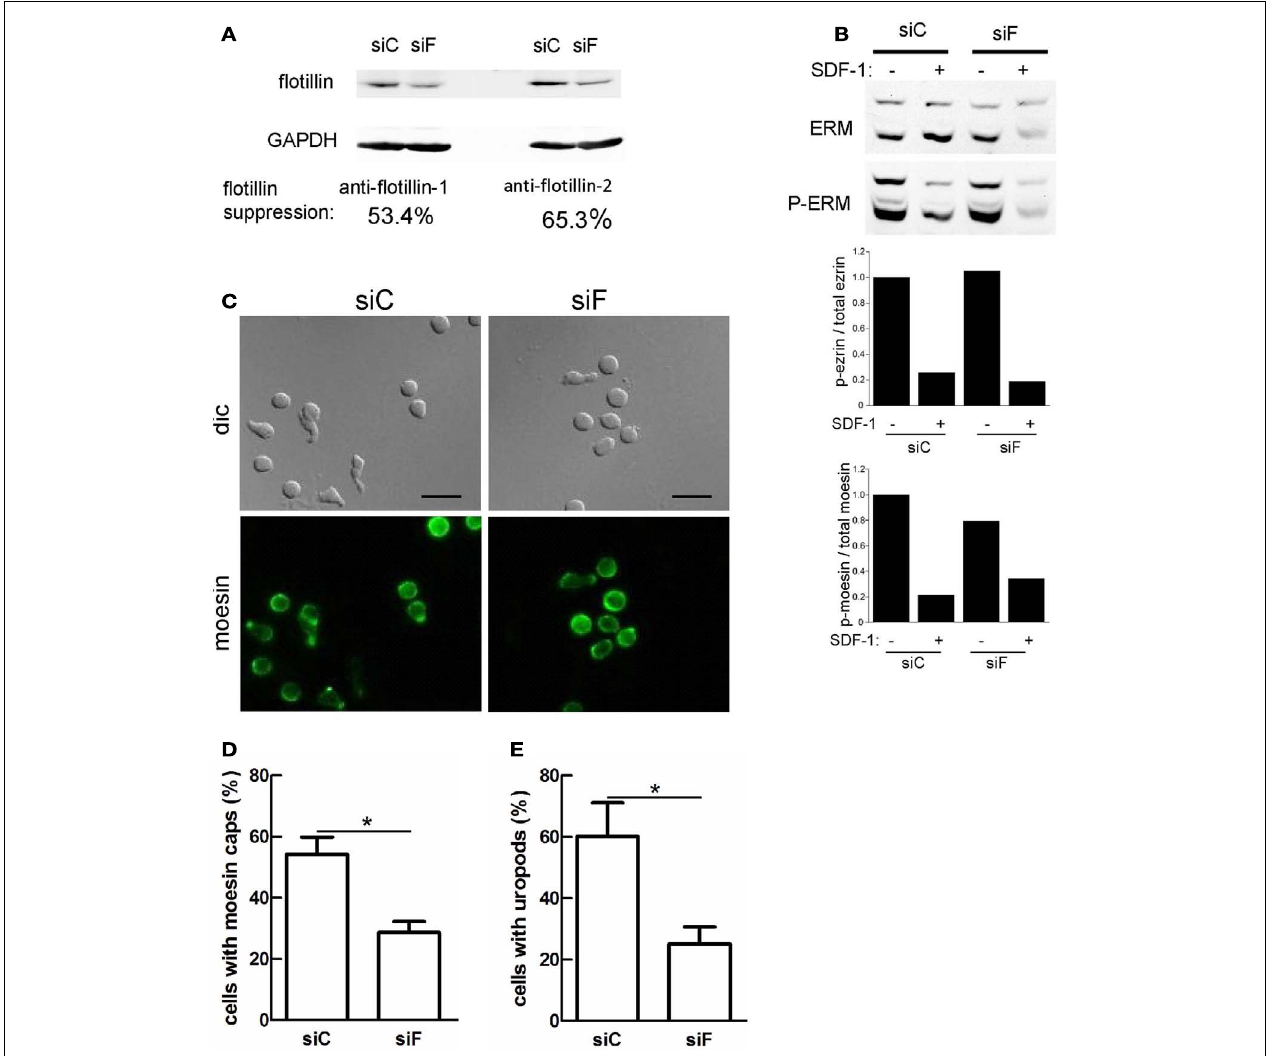
for phosphorylated moesin or ezrin, divided by values obtained for total moesin or ezrin, and normalized to the control sample). Data are from one experiment, representative of three. Note that the low signal in the siF + SDF-1 lane is due to underloading and is not reproducibly observed. (C–E) T cells prepared as in (A) were allowed to adhere to fibronectin-coated glass, fixed and stained for moesin (C) and the % of cells with moesin caps (D) and uropods (E) was evaluated. Bar, 10 µ m. (D,E) Mean ± SEM of four experiments; * P <